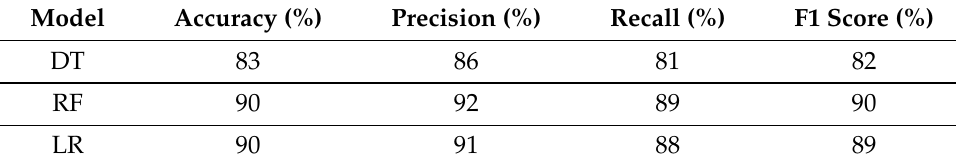
Table 15. Machine learning model performances on a VADER sentiment.